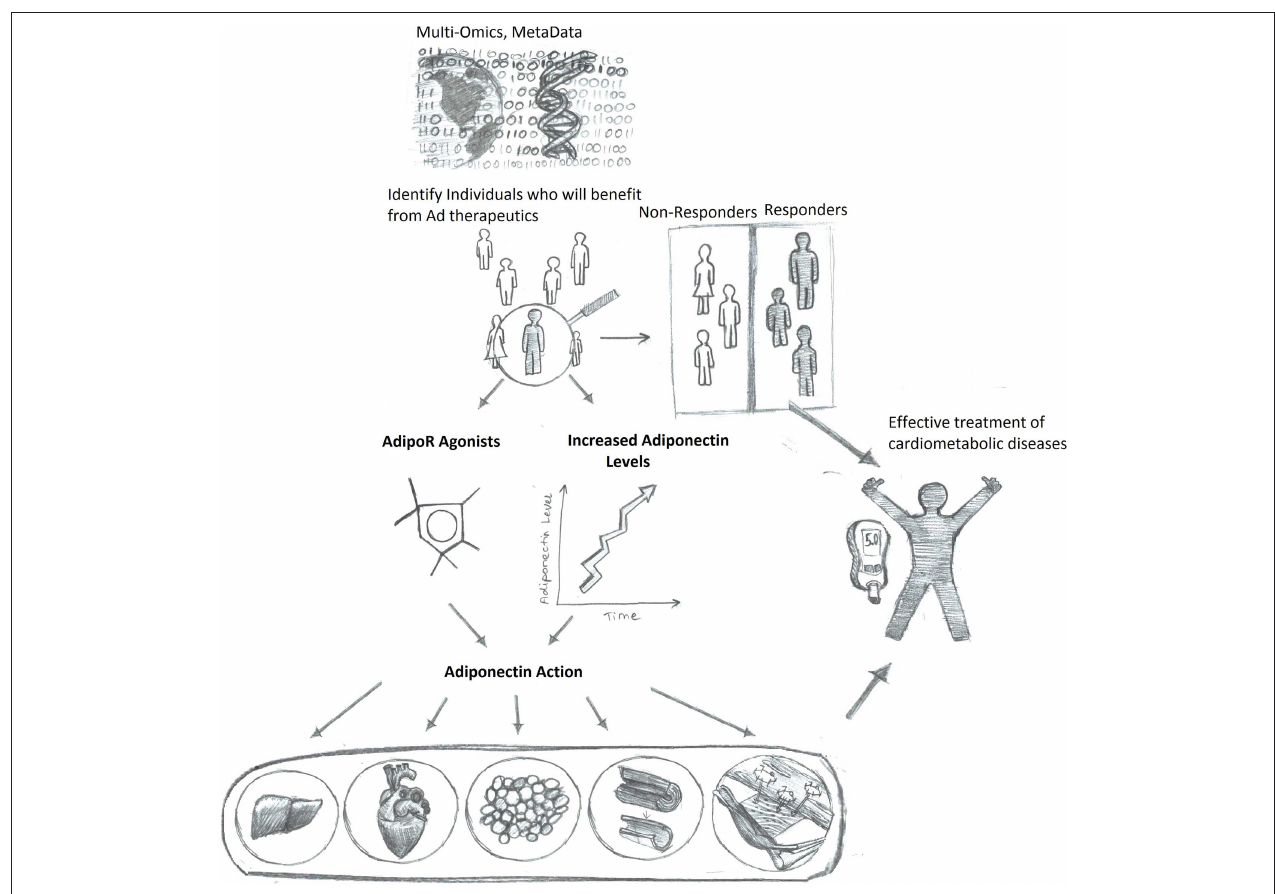
FIGURE 3 | Enhanced adiponectin therapeutics via precision medicine upon personalized response prediction. Accumulation of big data will allow algorithm-based prediction of those individuals most likely to benefit from therapeutic agents to either increase adiponectin levels or directly mimic adiponectin action, thus resulting in more efficient and improved health care